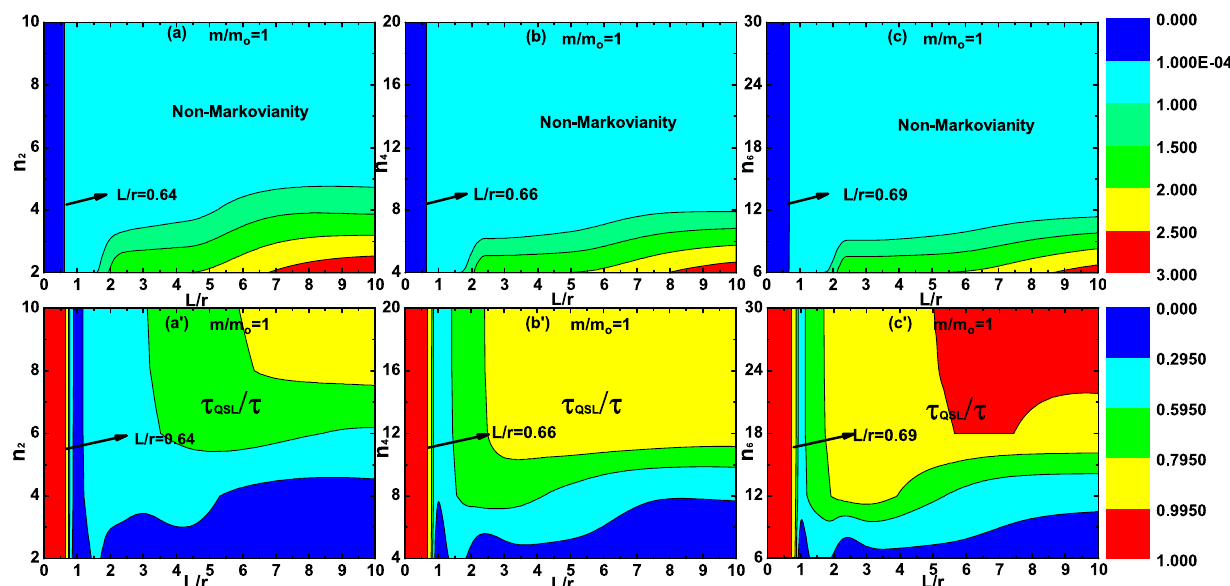
Fig. 4 For the two dimensional even ray case ( x = 2, x = 4 and x = 6), and the actual evolution time τ = 0 . 4s, r =250 µ m and m = m o =10 − 13 kg. a – c Non-Markovianity N (ϕ) ofthedynamicsprocess of the system particle m o as a function of L / r and the number of the